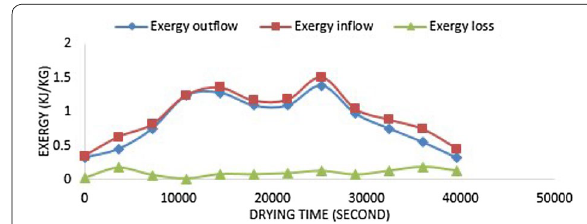
Fig. 9 Exergy as a function drying time (3rd day) potato